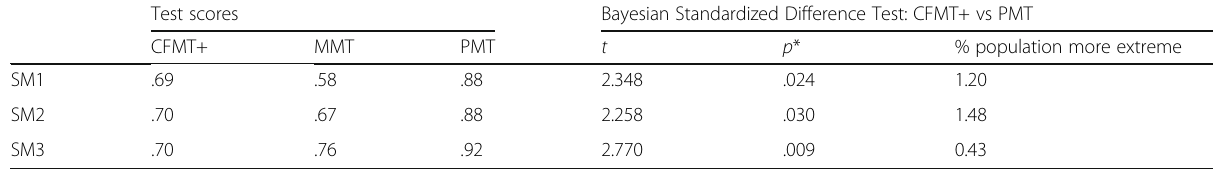
Table 9 Dissociation between face matching and face memory performance in three “ super matchers ” Test scores Bayesian Standardized Difference Test: CFMT+ vs